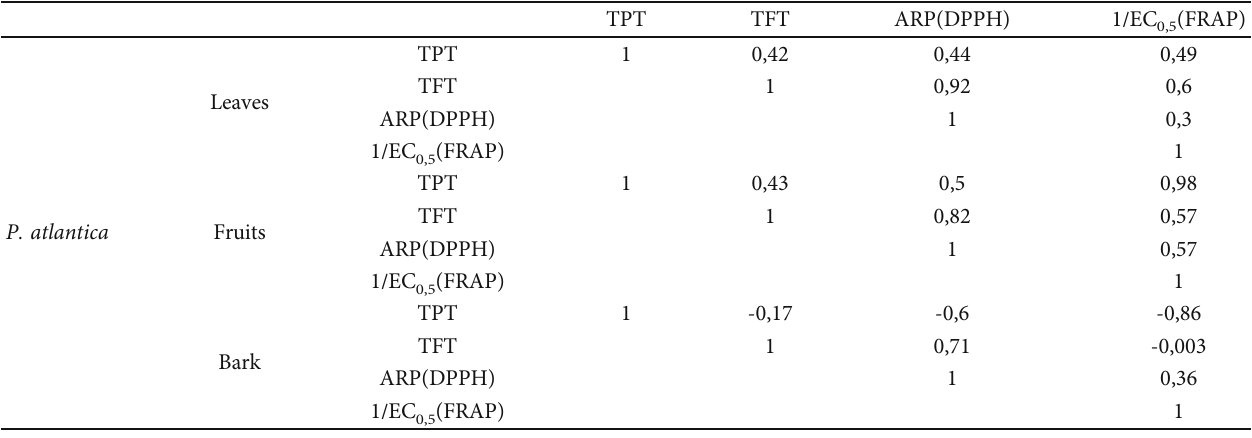
Table 2: Linear correlation coe ffi cients ( R 2 ) between the content of phenolic compounds and the antioxidant activity of the extracts studied.